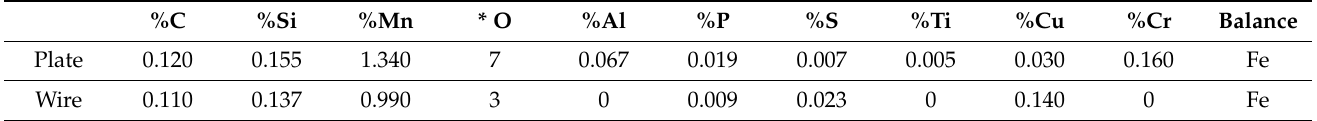
Table 1. Steel base plate and weld wire compositions (mass%).